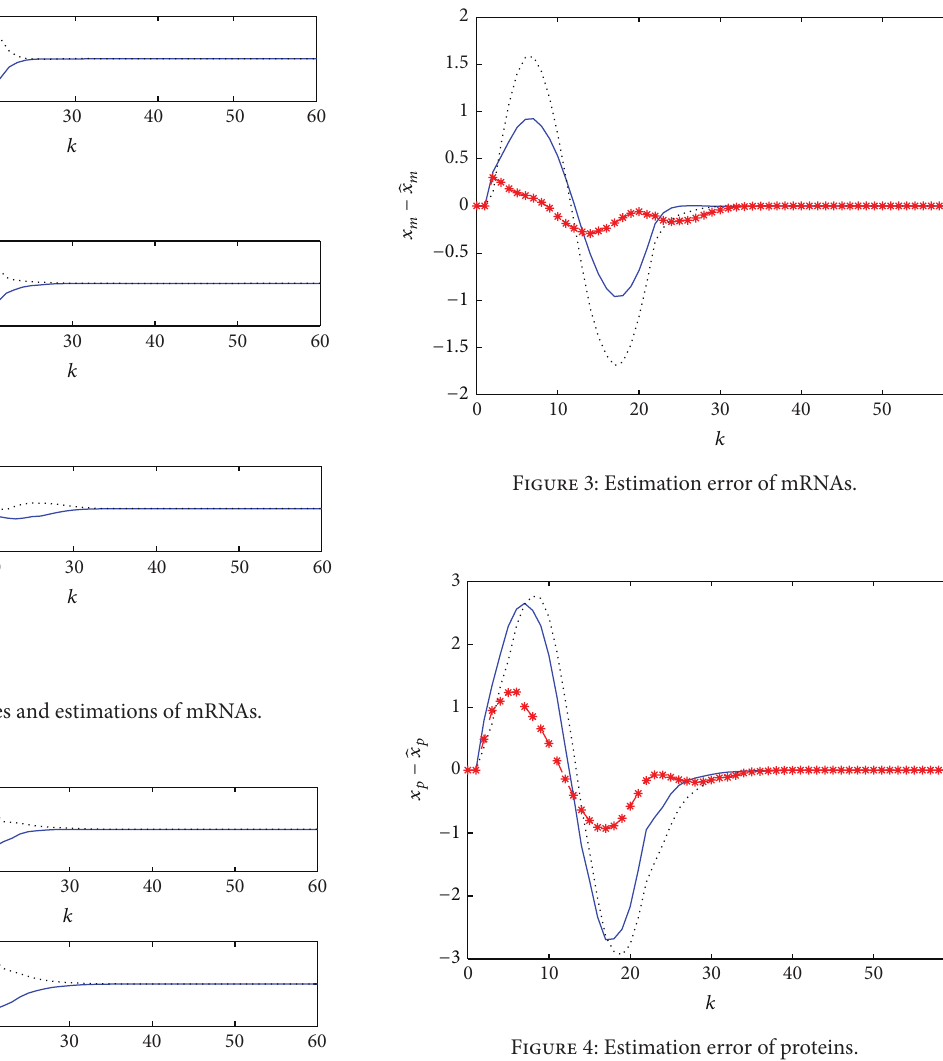
Figure 4: Estimation error of